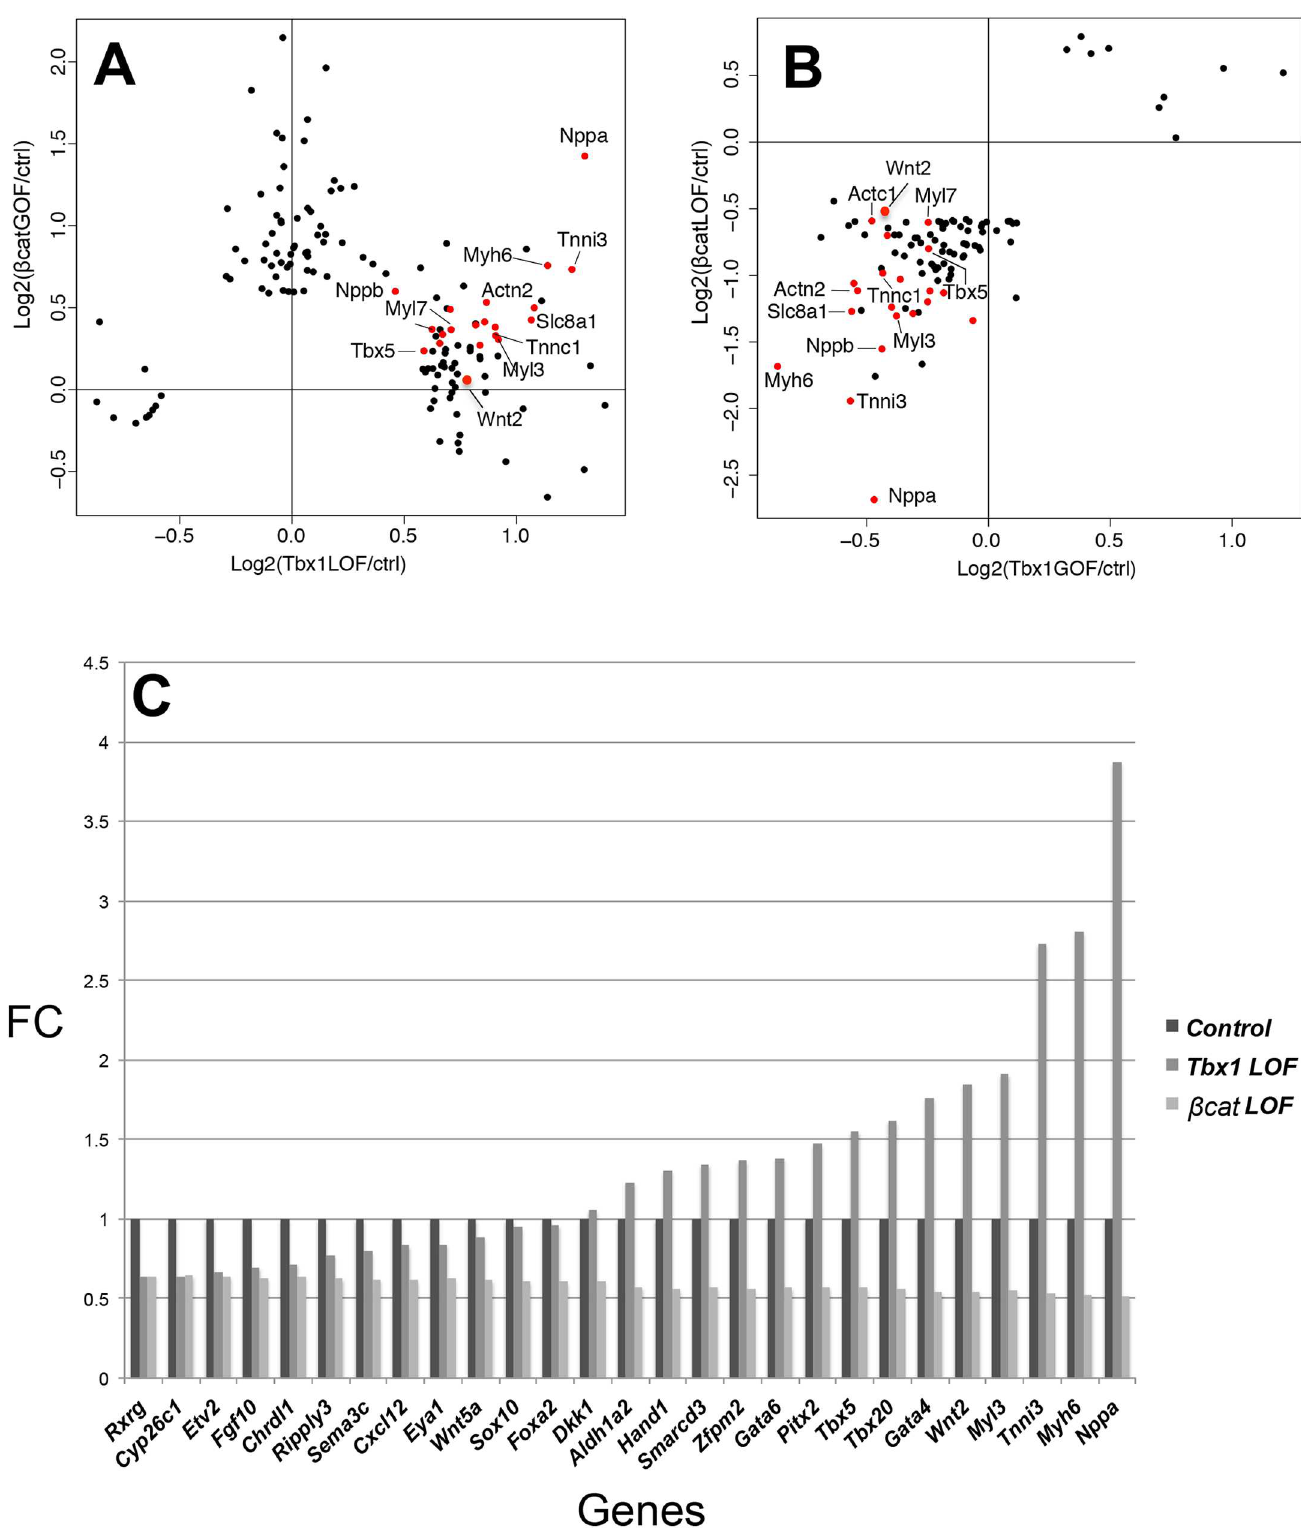
Fig 3. Opposing β -catenin and Tbx1 conditional mutants have sameeffect on expression of pro-differentiation genes in the AHF. (A) Comparison of globalgene expressionchangesin the micro-dissected AHF of β -cateninGOF and Tbx1 LOF embryos at E9.5. Plotted are differentially